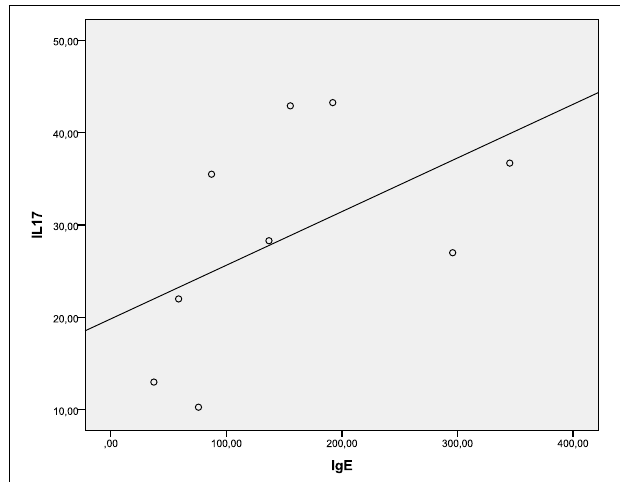
FIGURE 4 | Spearman’s rank correlation between systemic IL-17 and IgE concentrations in S . Enteritidis-infected patients. Spearman’s rho = 0.683 [significant at the 0.05 level